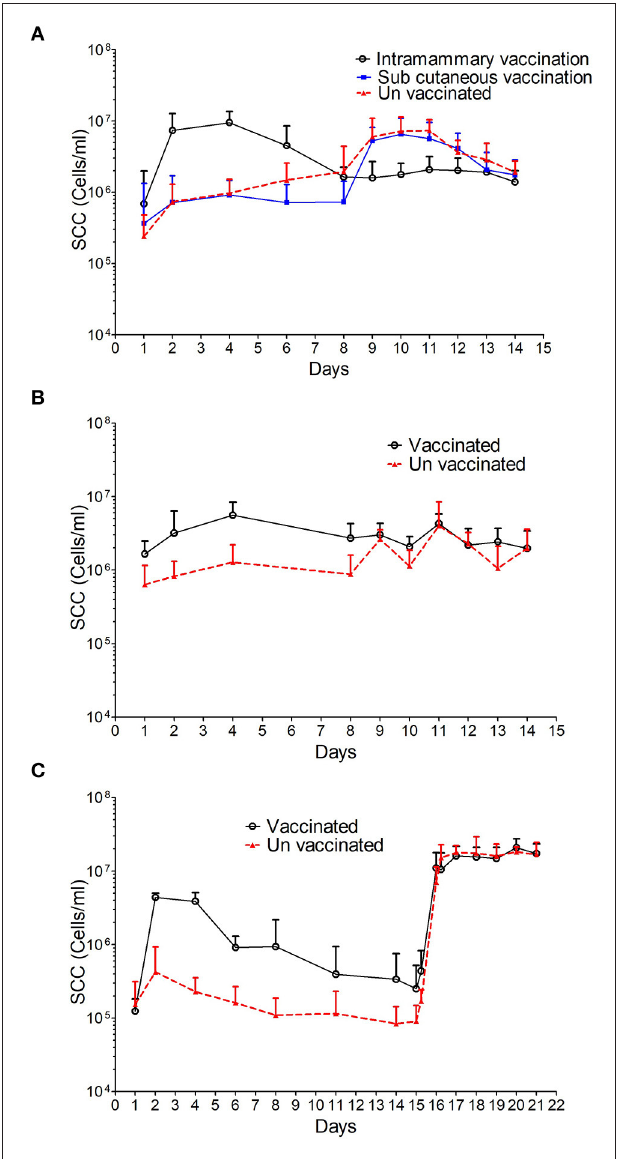
FIGURE 3 | SCC data from sheep immunised and challenged with M. haemolytica. The average SCC in cells/ml with standard deviation is shown for study 1 (A) where three groups are represented: i, intramammary immunisation; ii, sub-cutaneous immunisation and iii, unvaccinated controls; study 2 (B) where two groups are represented: i, intramammary immunisation and ii, un-vaccinated controls and study 3 (C) where 2 groups are represented: i, intramammary immunisation and ii, unvaccinated controls.